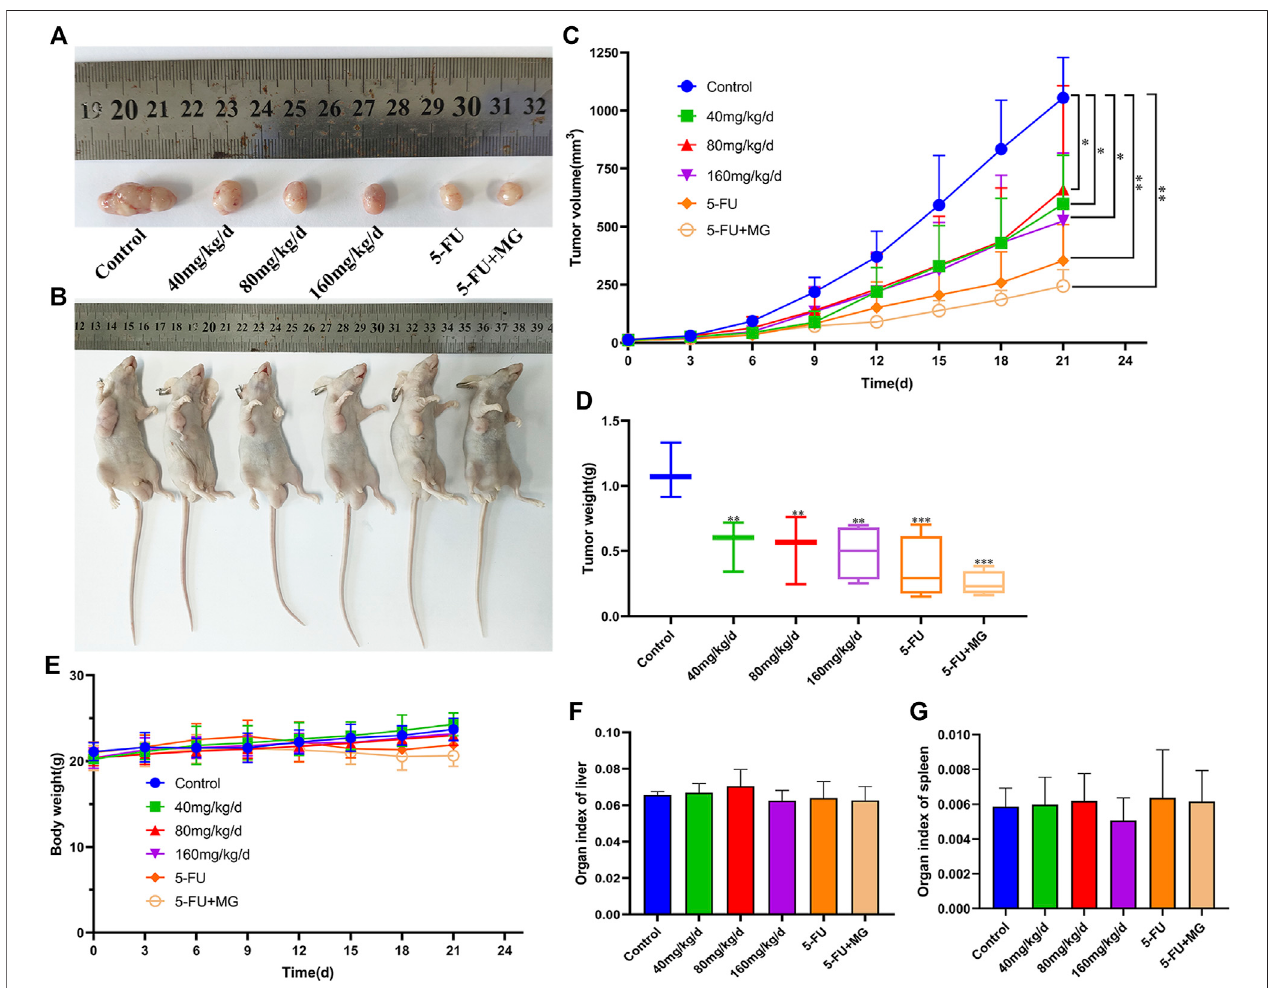
FIGURE 4| Methyl gallate(MG) inhibits tumor growth in vivo in BALB/Cnude mice. (A – B) Tumor anatomy and physical appearance of nude mice treated with MG and5-FU. (C) AnalysisoftumorgrowthvolumebyMGand5-FU. (D) EffectofMGand5-FUontumorweight. (E) In fl uenceofMGand5-FUonbodyweightofnudemice. (F – G) Effect of MG and 5-FU on liver and spleen indices of nude